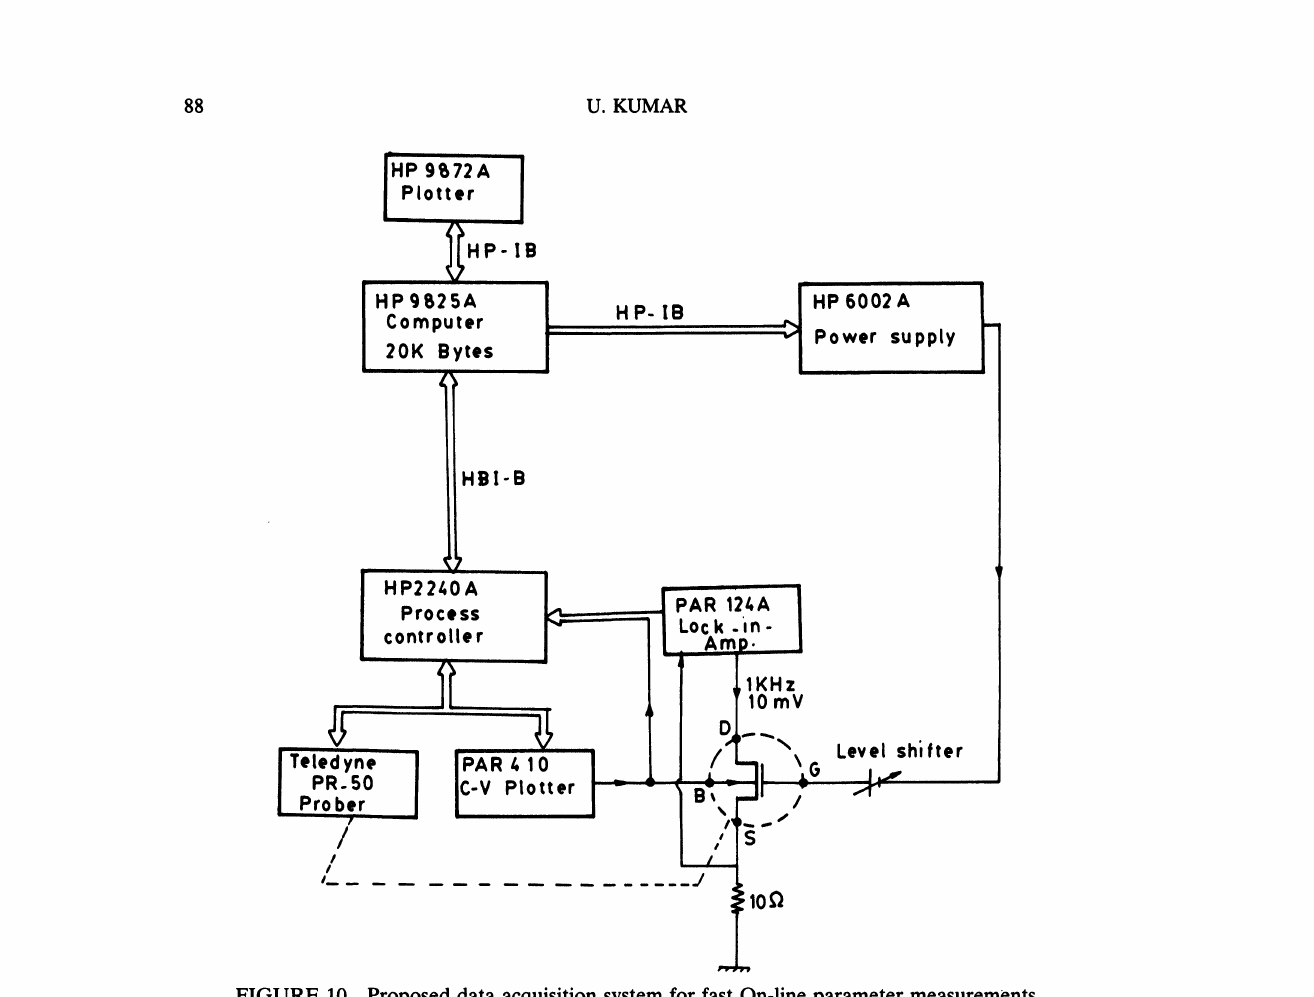
FGURE 10 Proposed data acquisition system for fast On-line parameter